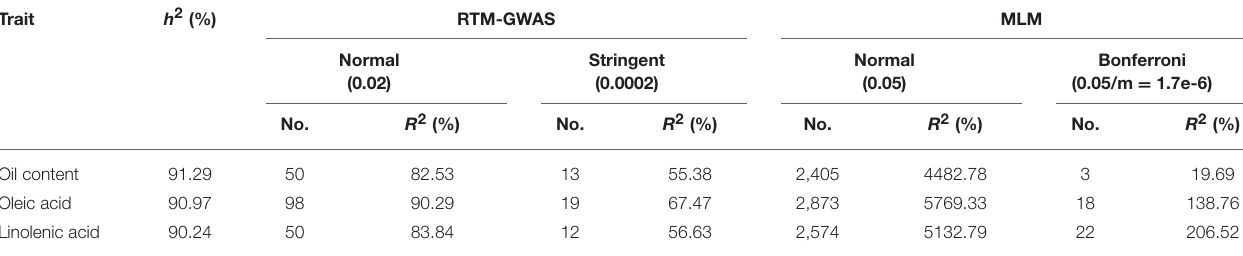
TABLE 2 | Comparisons of the GWAS results of the seed oil traits in CSLRP among the two association analysis procedures. Trait h 2 (%) RTM-GWAS MLM